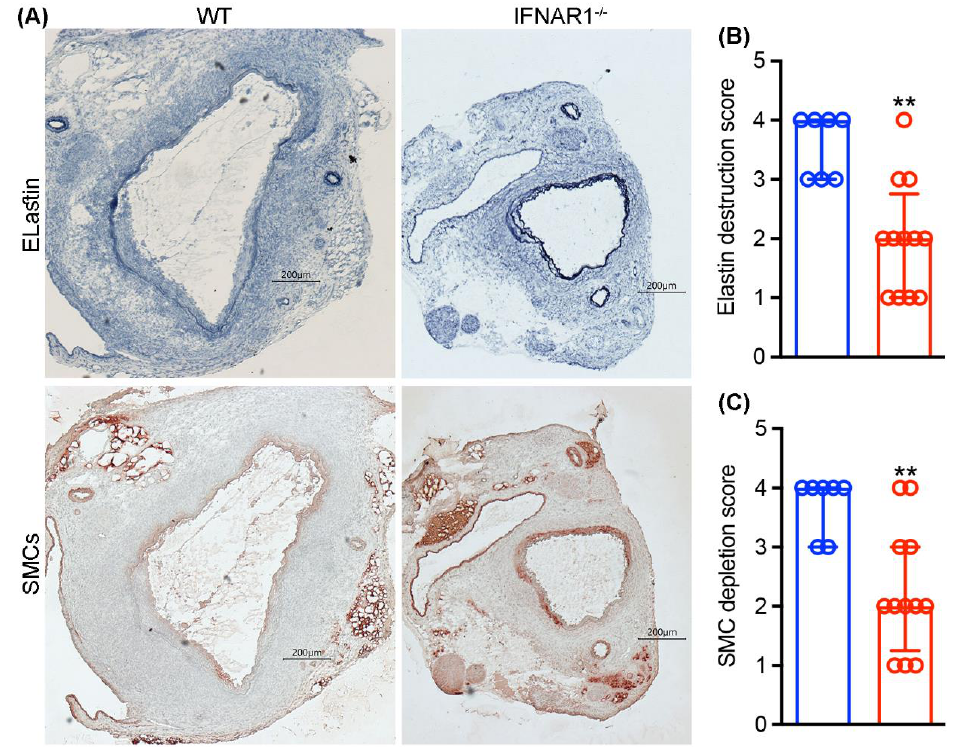
Figure 4. Type 1 IFN receptor subunit 1 deficiency reduces medial elastin degradation and smooth muscle cell depletion in experimental AAAs. Acetone-fixed aortic frozen sections were prepared from wild type (WT, n = 7) and type 1 IFN receptor subunit 1-deficient (IFNAR1 −/− , n = 12) mice 2 weeks after elastase infusion and stained using the Verhoeff’s Van Gieson (EVG) procedure and immunostaining for medial elastin and smooth muscle cells (SMCs), respectively. Elastin degradation and SMC depletion were graded as I (mild) to IV (severe). ( A ) Representative histologic images demonstrate relative medial elastin and SMC preservation in IFNAR1 −/− as compared to WT mice. ( B , C ) Quantification (median and interquartile) of medial elastin and SMC destruction scores between groups. Nonparametric Mann – Whitney test, ** p < 0.01 compared to WT mice. Scale bar: 200 µ